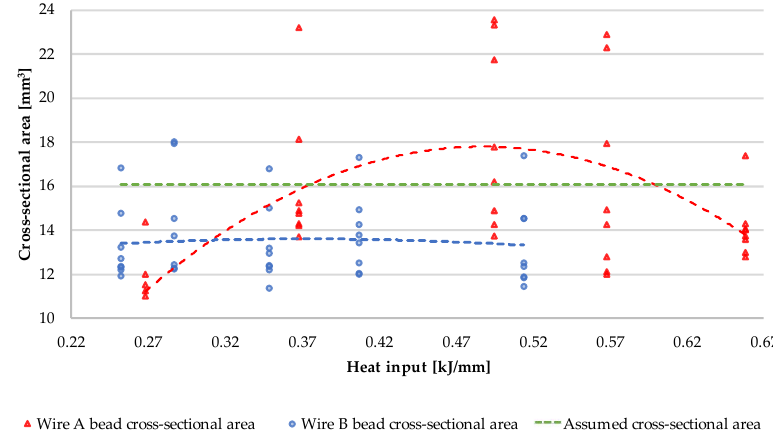
Figure 11. Graph representing the dependence of the cross-sectional bead area on the heat input. The red and blue dashed lines express the second order interpolation, while the green dashed line marks the assumed, target value for the reference.